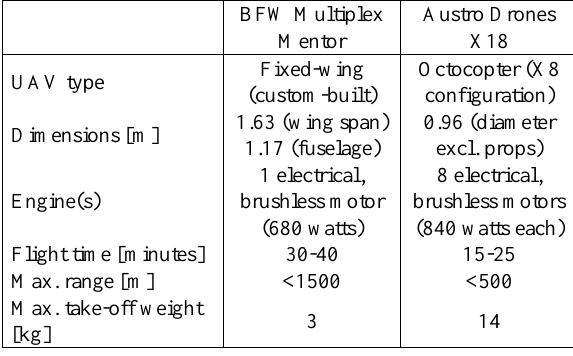
Table 3. Technical specifications of UAS